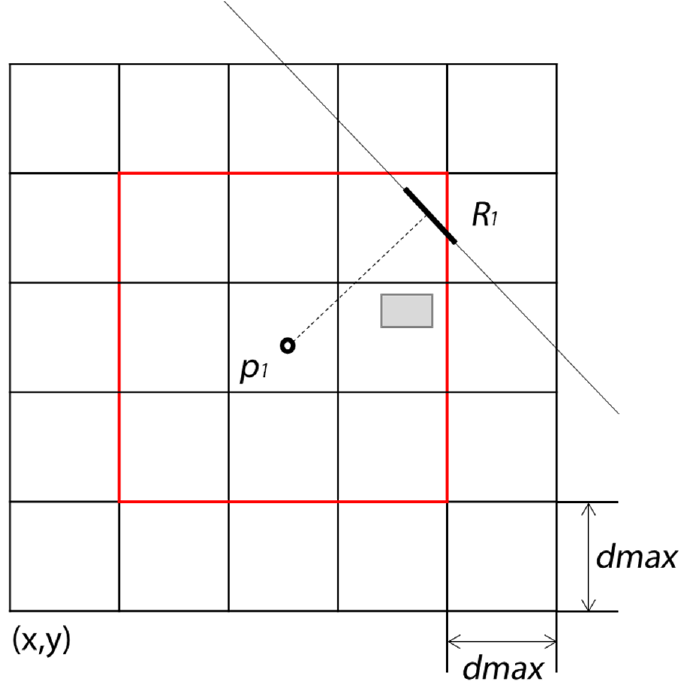
Figure 6. Two-dimensional grid for receiving points, road segments and